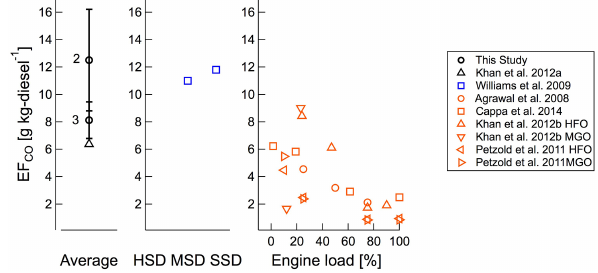
Figure 13. Emission factors for CO; fuel type (HFO: heavy fuel oil with high sulfur content, and MGO: marine gas oil with low sulfur content), or vessel class based on gross metric tonnage (HSD: high speed diesel < 5000t, MSD: medium speed diesel 5000–30000t, or SSD: slow speed diesel > 50000t); plumes 2 and 3 are indicated on the plot with numbers 2 and 3 and the estimated uncertainty is shown by error bars (plume 1 emission factor is not shown due to the large